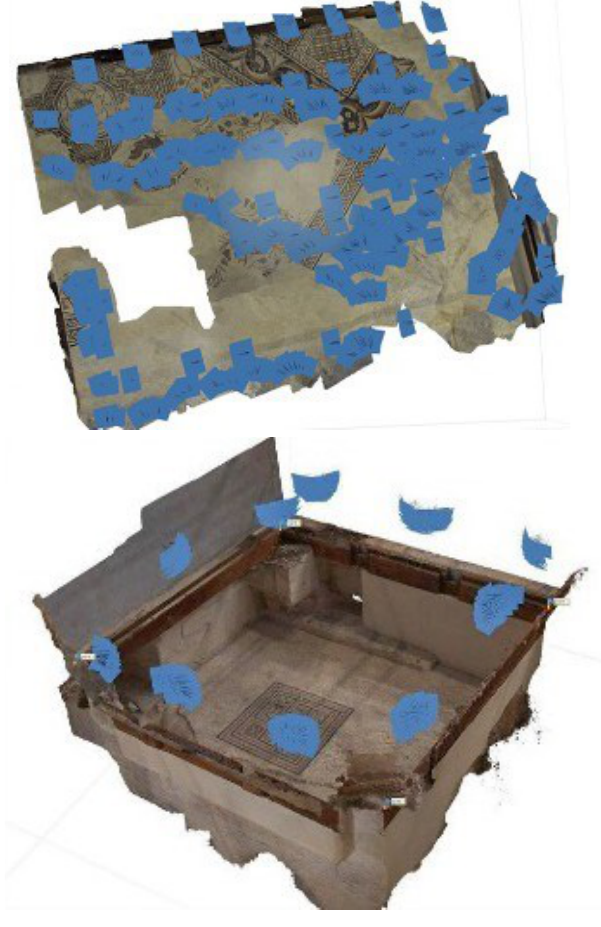
Figure 14. 3D models of mosaic B (above) and mosaic C (below) obtained by SfM photogrammetry. In case of